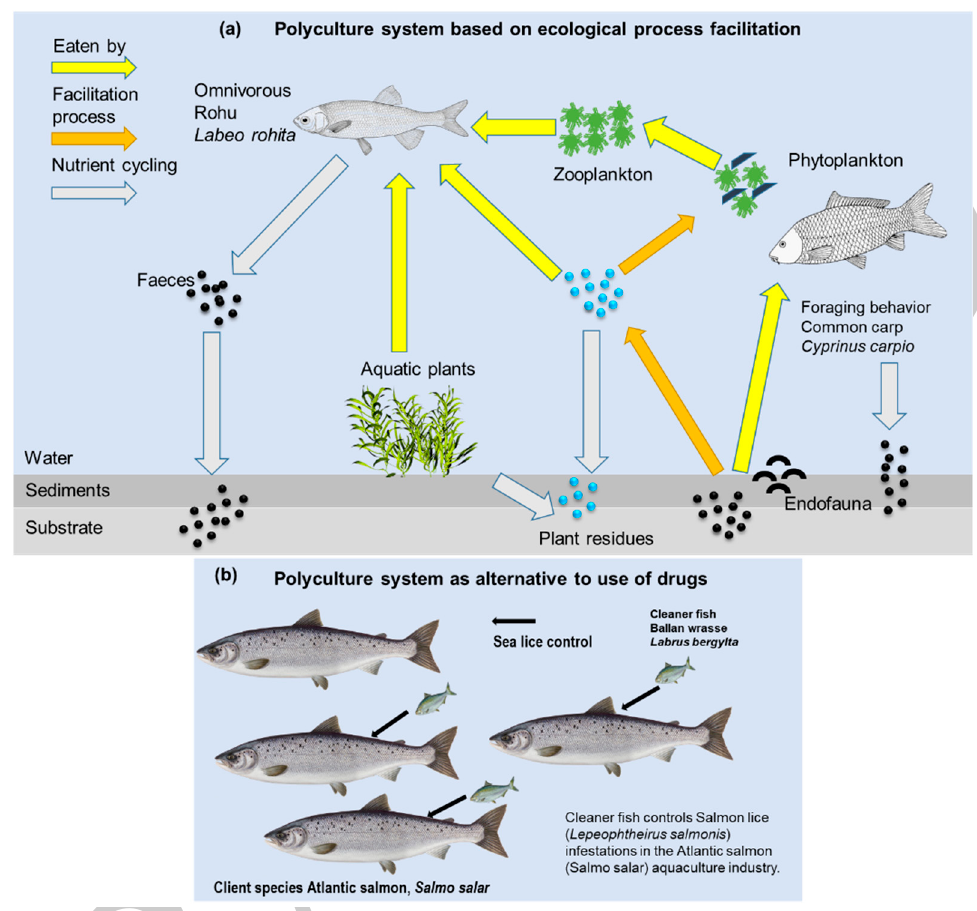
Figure 4. Graphical illustration of a polyculture system based on enhanced species complementarity through beneficial interactions amongst combined fish species. ( a ) Polyculture system based on commensalism, a positive interaction among fish species. The foraging behavior of one fish species enhances feed resource availability needed for another fish species by playing a role in the resuspension of nutrients accumulated at the sediment layer from the water column. ( b ) Polyculture system based on the principle of mutualism between fish species. Both the fish species benefit from being cultivated together, e.g., in cage systems. Here, a cleaner fish protects client fish by controlling sea lice as stated in the previous report [152].